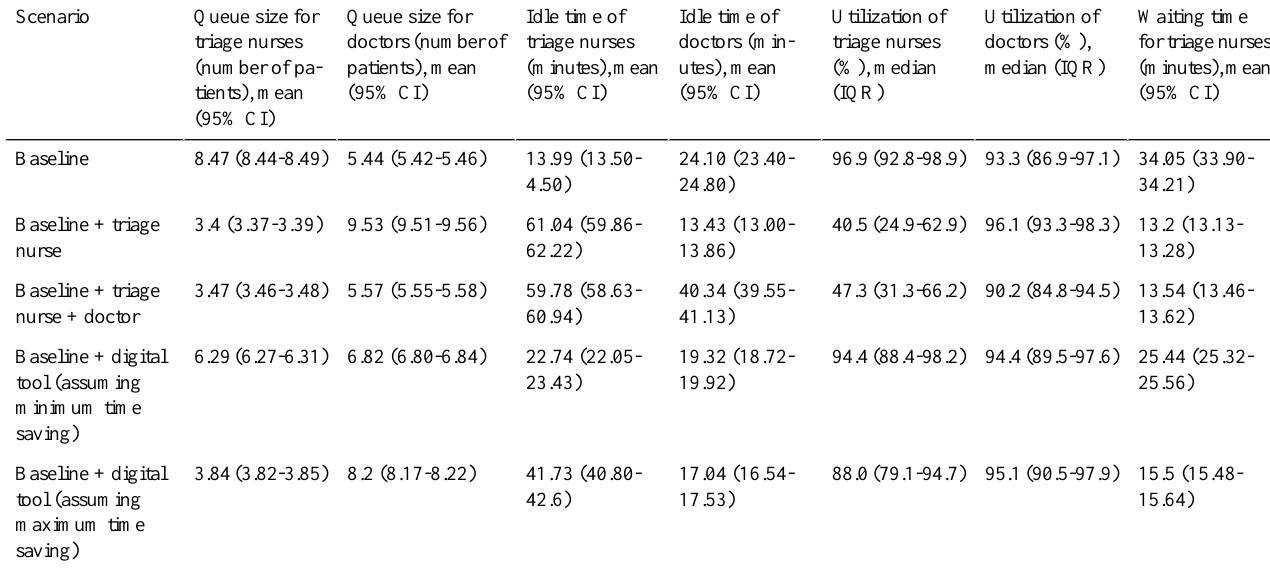
Table 2. Effect of adding extra staff or using a digital symptom and history-taking app on queue sizes, idle time, and utilization of staff members, and patient waiting time for the triage